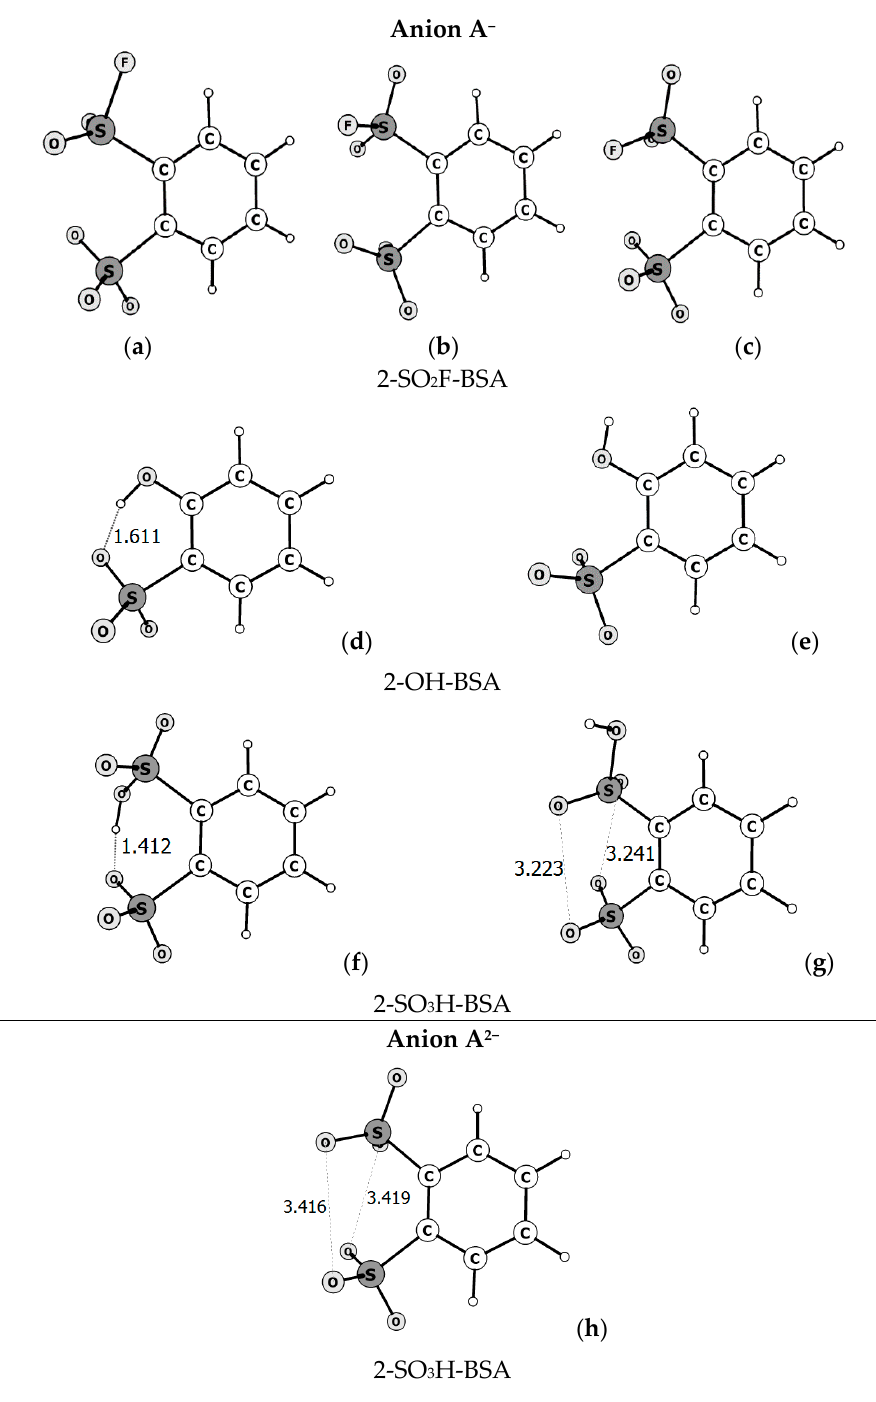
Figure 12. The deprotonated forms structure of A − acid 2-SO 2 F-BSA ( a – c ), 2-OH-BSA acid ( d , e ) and forms A − ( f , g ) and A 2 − ( h ) acid 2-SO 3 H-BSA.